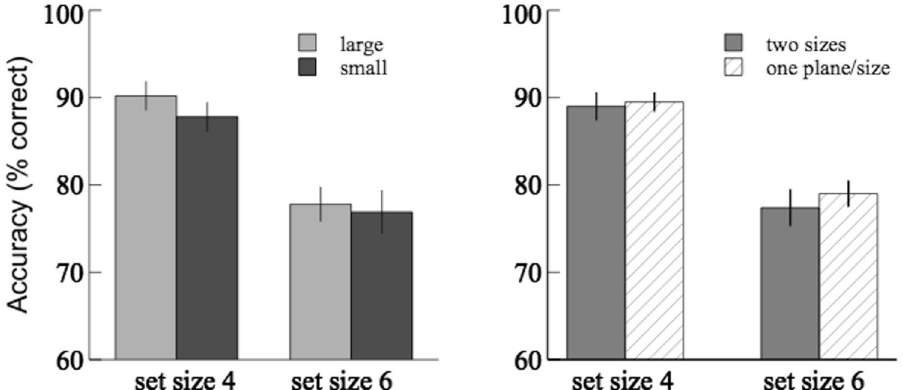
Figure 3. Results of Experiment 2. Comparisons of the average change detection accuracies between the large items and the small items were shown on the left; comparisons between the two-sizes condition and the one- plane/size condition were shown on the